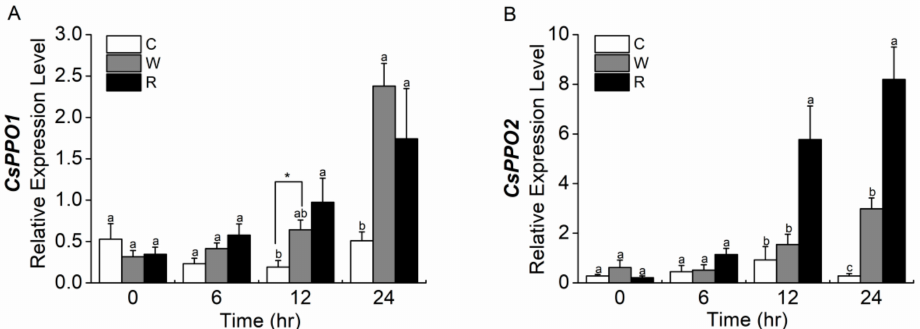
Figure 7. Mean levels of transcriptional expression ( ± SE) of ( A ) CsPPO1 and ( B ) CsPPO2 in treated tea leaves elicited by mechanical wounding supplemented with distilled water or regurgitant and intact control plants (C). CsGAPDH was used as a reference gene. For each time point, different letters indicate significant differences among treatments ( p < 0.05, Duncan’s multiple range test, n = 5). The asterisks indicate significant differences between treatments and controls (* p < 0.05, Student’s t -test, n = 5).